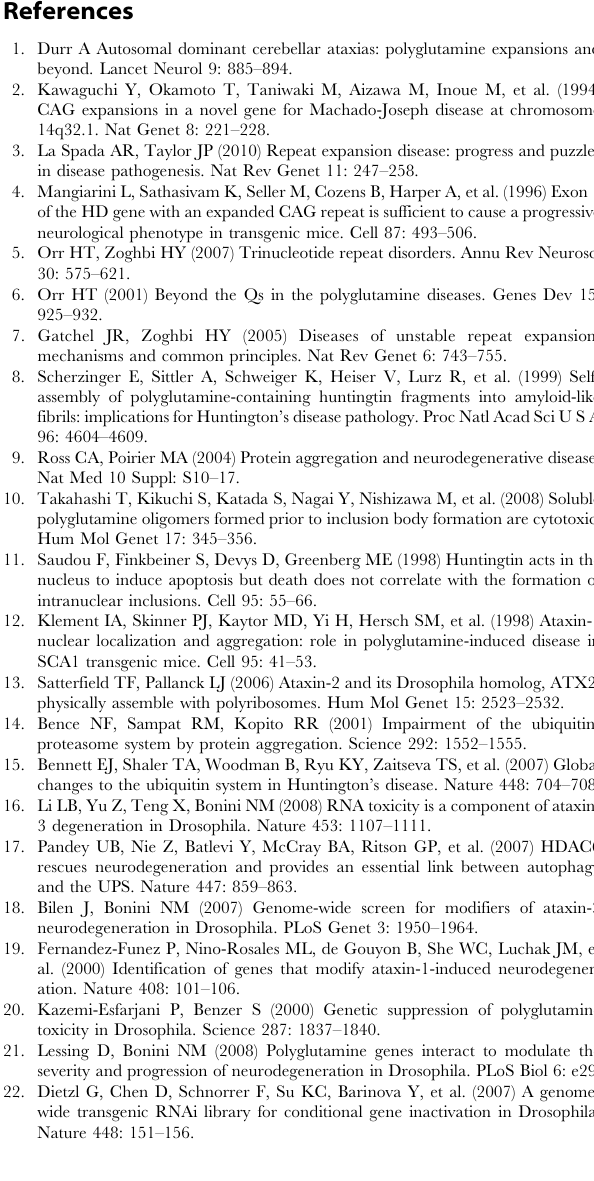
Table S2 Rescue of lethality induced by pan-neural polyQ expression. Table lists transformant ID (from VDRC), gene ID and gene name (if applicable) of all RNAi lines (genes silenced) which were tested for rescue effects on elav . polyQ - induced lethality. In the F1 generation ( elav . polyQ in combination with respective RNAi line), effects of gene silencing were categorized as rescue (R) if vital offspring was observed, or lethal (L) if no vital offspring was present. Control ( white RNAi) is marked in grey. Lines not available for rescue experiments are marked as not analyzed